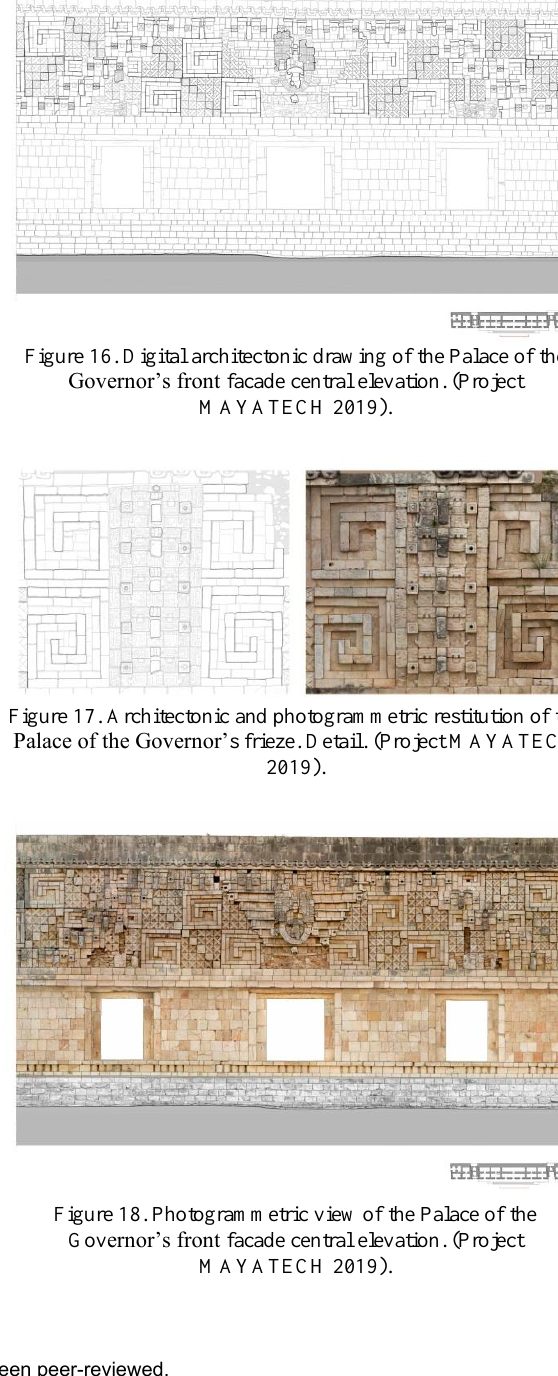
Figure 13. Hand sketch of the Palace of the Governor’s front facade central elevation. (Project MAYATECH 2018).